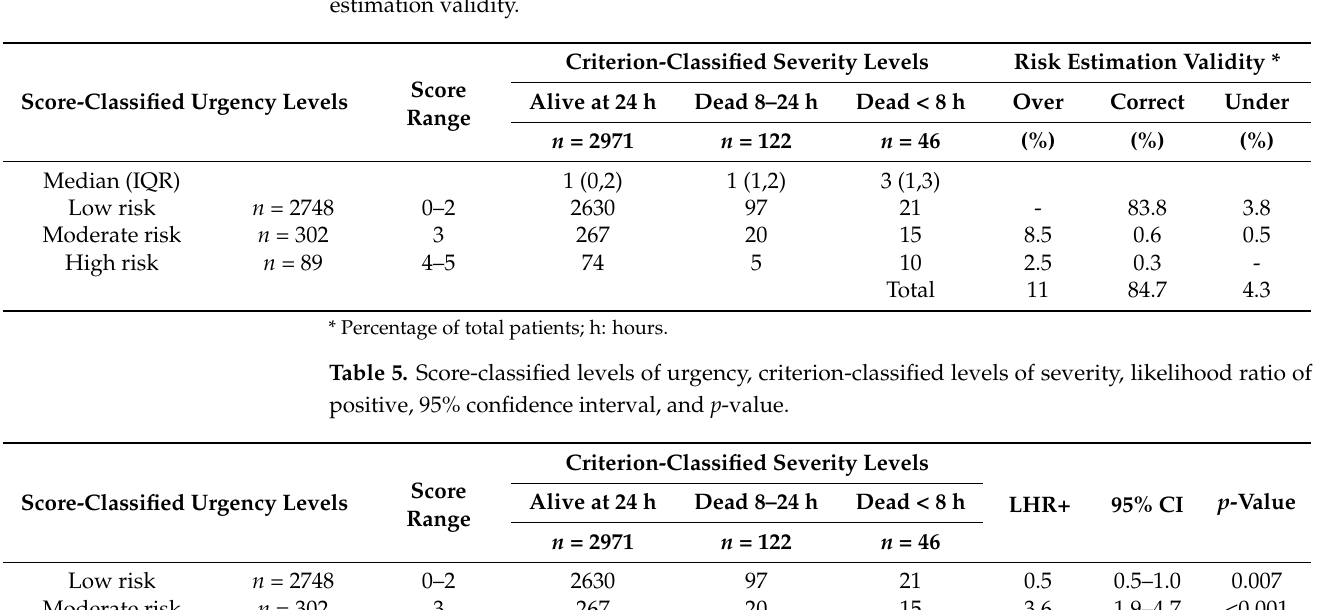
Table 4. Score-classified levels of urgency, criterion-classified levels of severity, and validity of risk estimation validity.